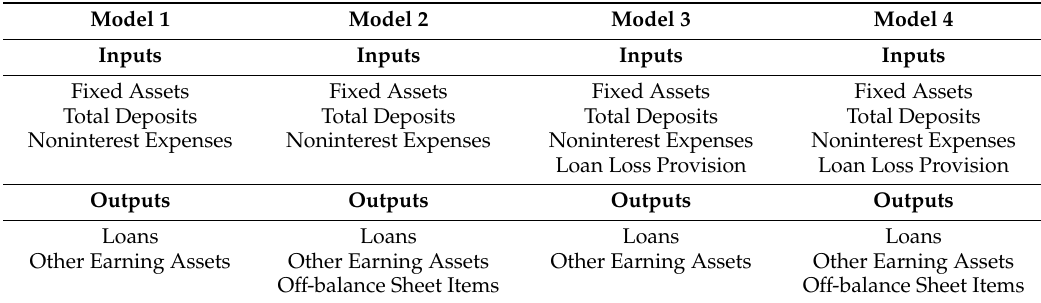
Table 1. Input and output specifications for Models 1 to